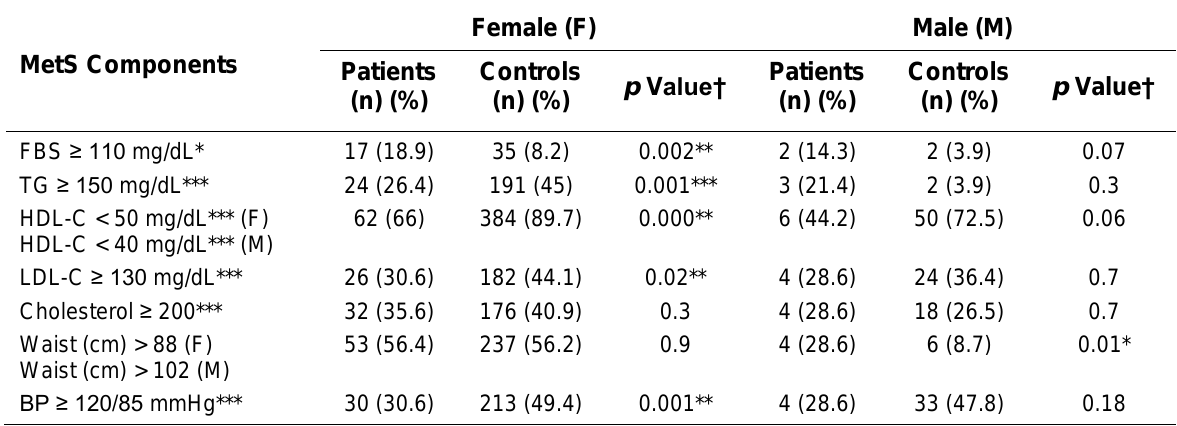
Correlation between RA Disease Activity and Presence of MetS